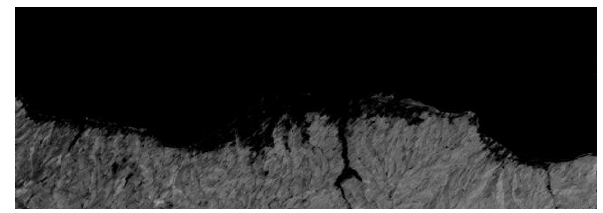
Figure 5. NDVI image - 06.10.2006